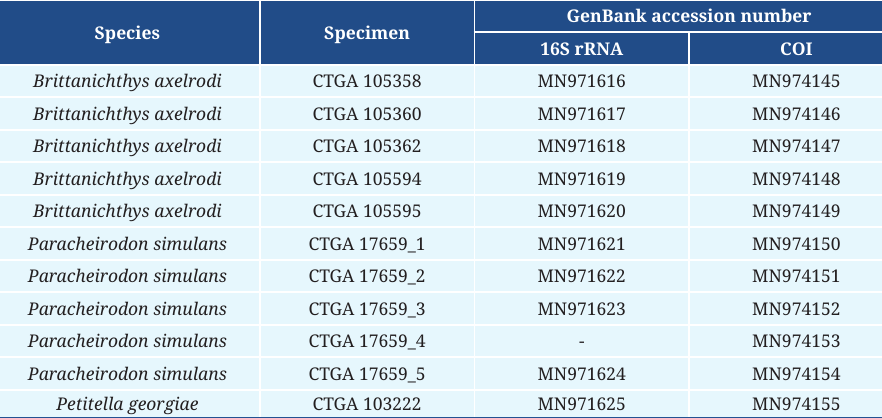
TABLE 1 | Specimens analyzed in this study. Species listed are valid names. Collection abbreviations are as follows: CTGA, Coleção de Tecidos de Genética Animal, Universidade Federal do Amazonas, Manaus, Brazil.